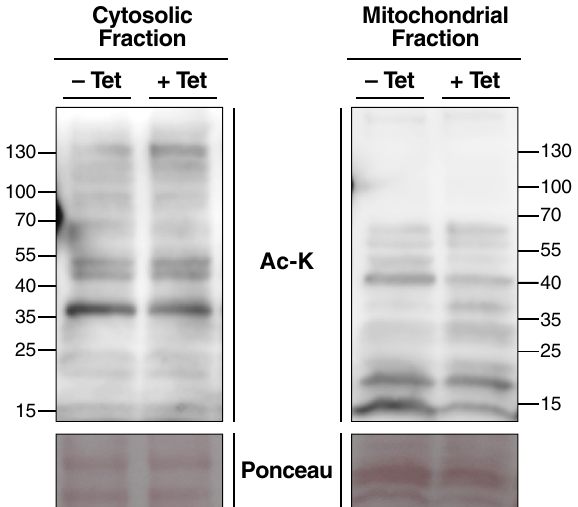
Figure 2. Overexpression of mt-ELP3 does not affect mitochondrial protein acetylation. Western blot analysis of lysine acetylation (Ac-K) status in mitochondrial and cytoplasmic fraction isolated from T-REx-293 cells treated (+Tet) or not (−Tet) with tetracycline. Ponceau was used as a loading